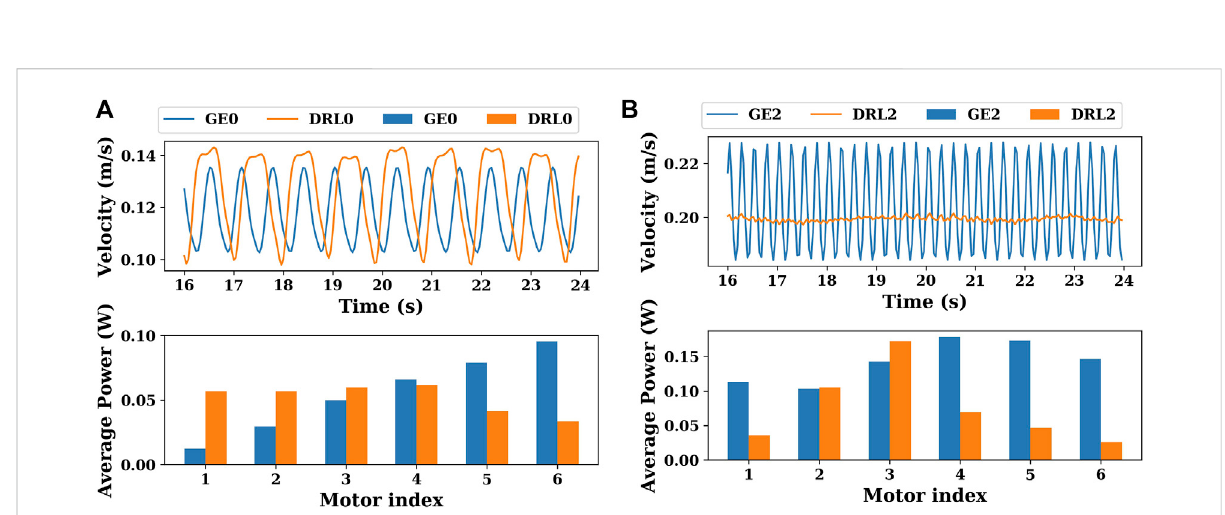
FIGURE 11 (A) Variation of the CoM velocitiesand the energy consumption of each joint of gaits GE0 and DRL0 (joint stiffness = 0Nm/rad). (B) Variation of the CoM velocities and the energy consumption of each joint of gaits GE2 and DRL2 (joint stiffness = 2